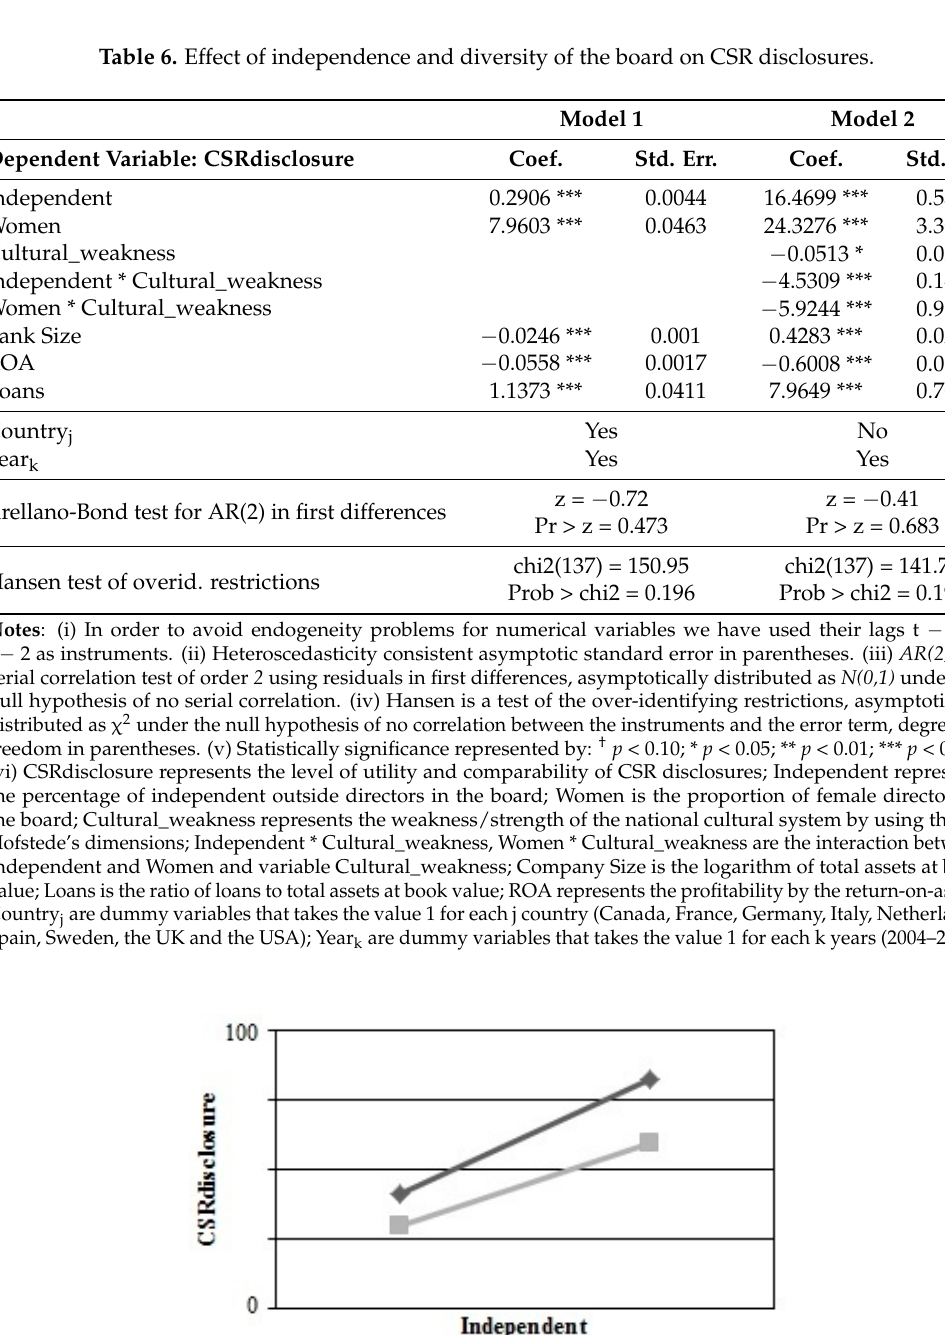
Table 6. Effect of independence and diversity of the board on CSR disclosures.